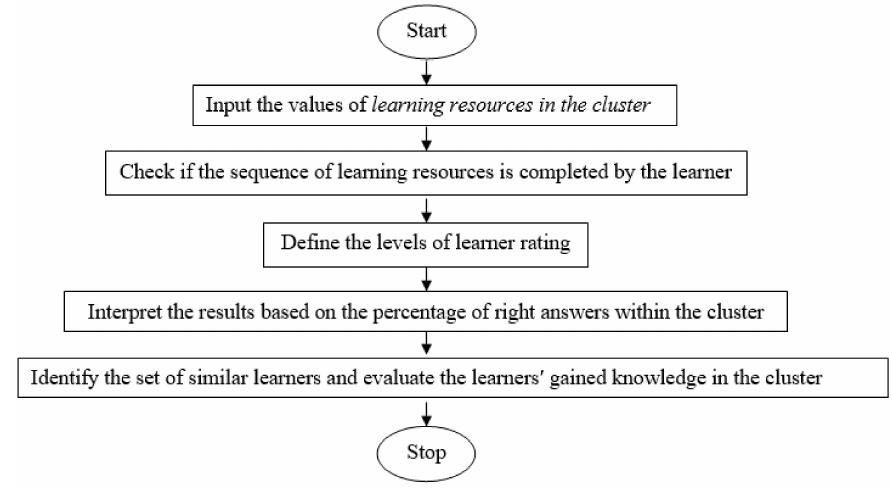
Figure 6. The proposed cluster-based evaluation.